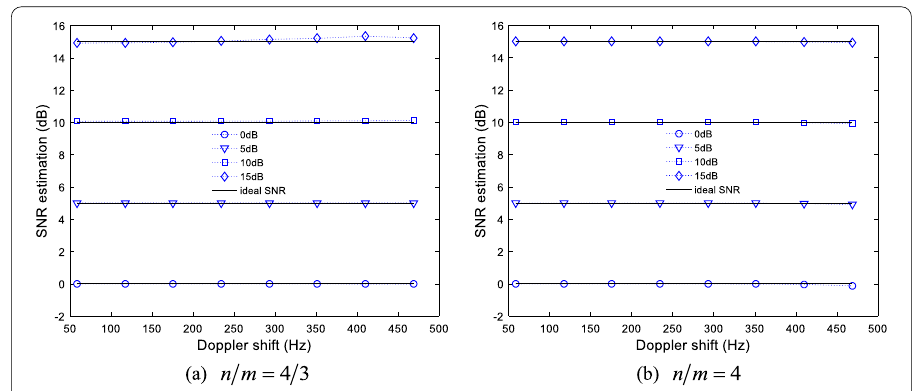
Fig. 6 The SNR estimation performance of the optimized ACF-DSR estimator